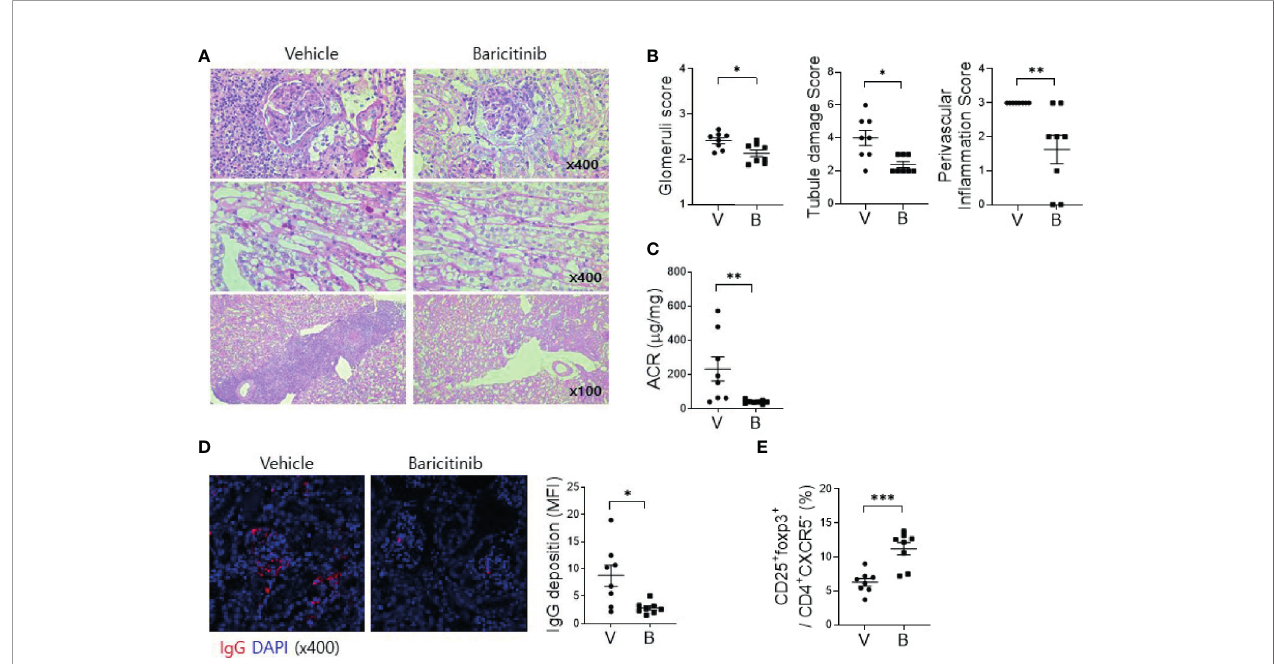
FIGURE 3 | Baricitinib ameliorates autoimmune kidney damage in MRL/ lpr mice. (A) Representative images of PAS staining of kidney sections from each group of MRL/ lpr mice treated with baricitinib (B) or vehicle (V), showing glomerular pathology (top), tubular damage (middle), and perivascular cell accumulation (bottom). (B) Glomerular pathology score, tubular damage score, and the degree of perivascular cell accumulation are shown. (C) Urinary albumin and creatinine (Cr) levels from each group of mice at the age of 16 weeks were measured by ELISA. Albumin/Cr ratio (ACR) is shown. (D) Representative confocal microscopic images of kidney sections from MRL/ lpr mice. Tissue sections were stained with fl uorescence-conjugated antibodies to IgG (red) (original magni fi cation ×400). IgG-positive area was calculated using ImageJ software. Mean fl uorescence intensity (MFI) are presented (right panel). (E) Flow cytometric analysis showing populations of CD4+CD25+ CXCR5-FOXP3+ cells (Treg cells) in kidney tissues from MRL/lpr mice. The percentage of Treg cell population among total lymphocytes is shown. Data are expressed as mean ± SD. * p < 0.05; ** p < 0.01; *** p <